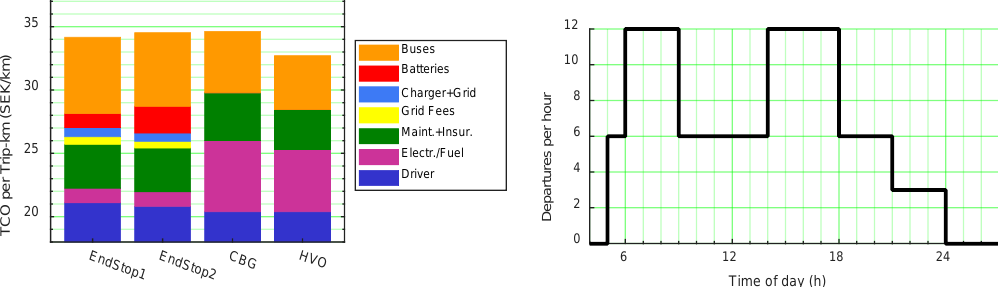
Figure 12. The cost of different types of buses on the reference bus route and with the reference timetable. EndStop1 and 2 buses are powered by electricity, while the others are powered by biogas (CNG) or biodiesel (HVO). (Note that the y -axis starts at 18 SEK / km, so the driver cost is more than half the TCO).